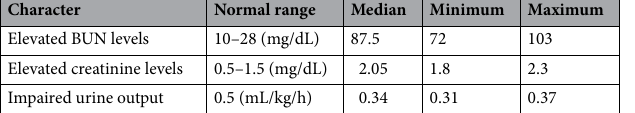
Table 4. Renal functions of patients, which developed acute kidney injuries ( n =